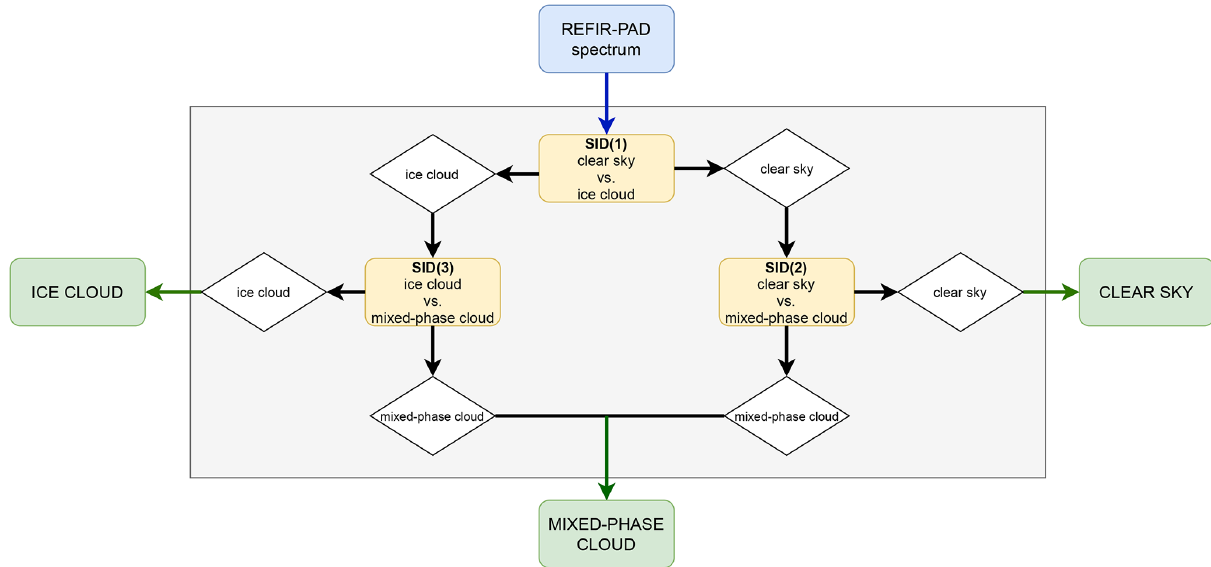
Figure 3. Logical diagram of the classification process performed by the CIC algorithm for the definition of the clear-sky, ice cloud, and mixed-phase cloud classes.